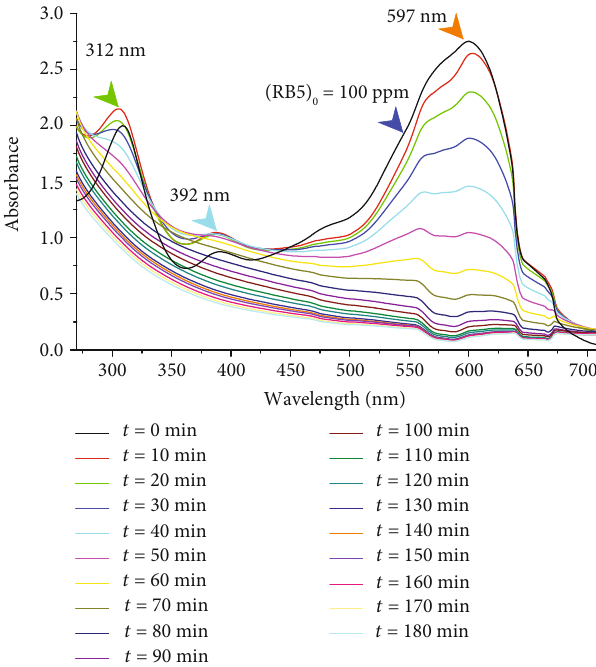
Figure 9: UV-Vis spectra of RB5 dye degradation by heterogeneous photo-Fenton process using